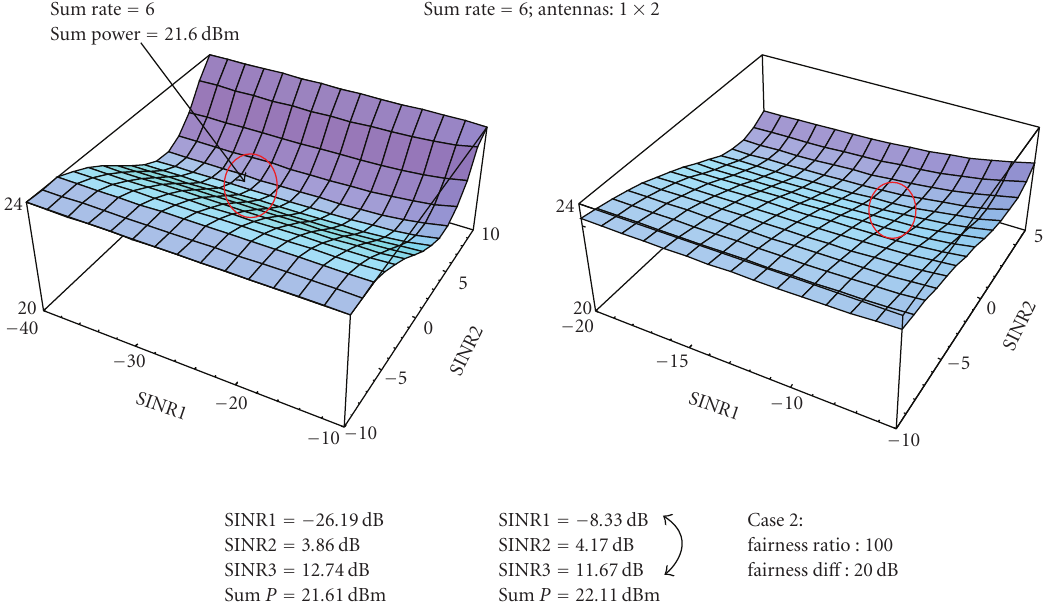
Figure 2: Sum power minimization. The figure shows the sum power as the function of SINR1 and SINR2 without fairness constraints (left) and for Case 2, when the ratios between the lowest and highest SINR must not be greater than 100. In this case the sum power is somewhat higher (22.11 dBm) than without fairness constraint